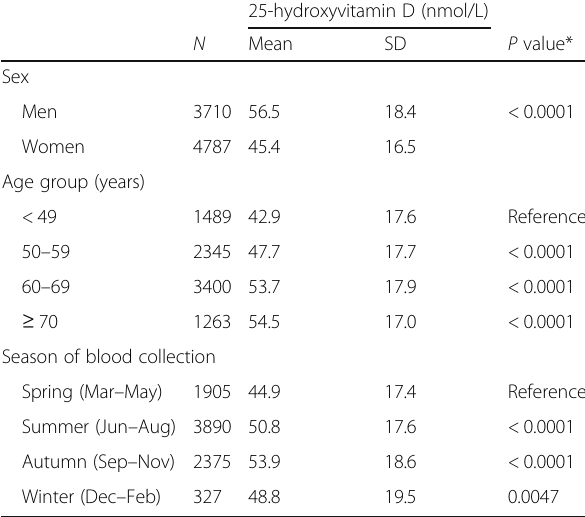
Table 4 Mean plasma 25-hydroxyvitamin D concentrations and standard deviations (SDs) by sex, age group, and season in